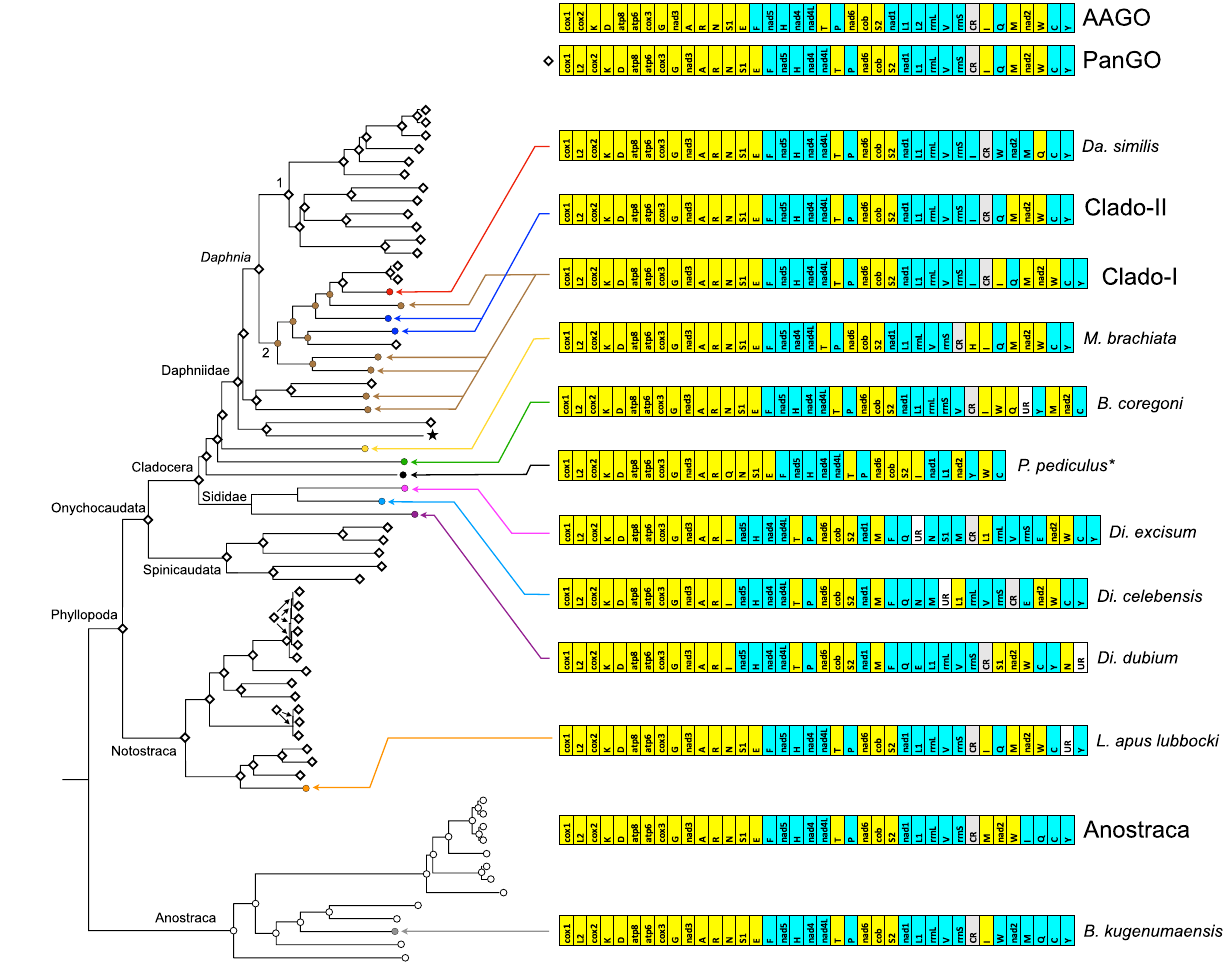
Figure 2. Schematic drawing of observed mitogenome gene orders (GOs) with their phylogenetic distribution. Numbers in the Daphnia clade indicate the two subgenera Daphnia (1) and Ctenodaphnia (2). Yellow and cyan genes colour indicate they are coded on the two different strands. AAGO Ancestral Arthropod Gene Order, PanGO Pancrustacea Gene Order. Clado-I gene order pattern is shared by: Da. lumholtzi , Da. barbata , Da. dolichocephala , C. reticulata and Si. serrulatus . Clado-II gene order pattern is shared by: Da. magna and Da. hispanica . Asterisk on P. pediculus indicates it is an incomplete genome. The star indicates the position of